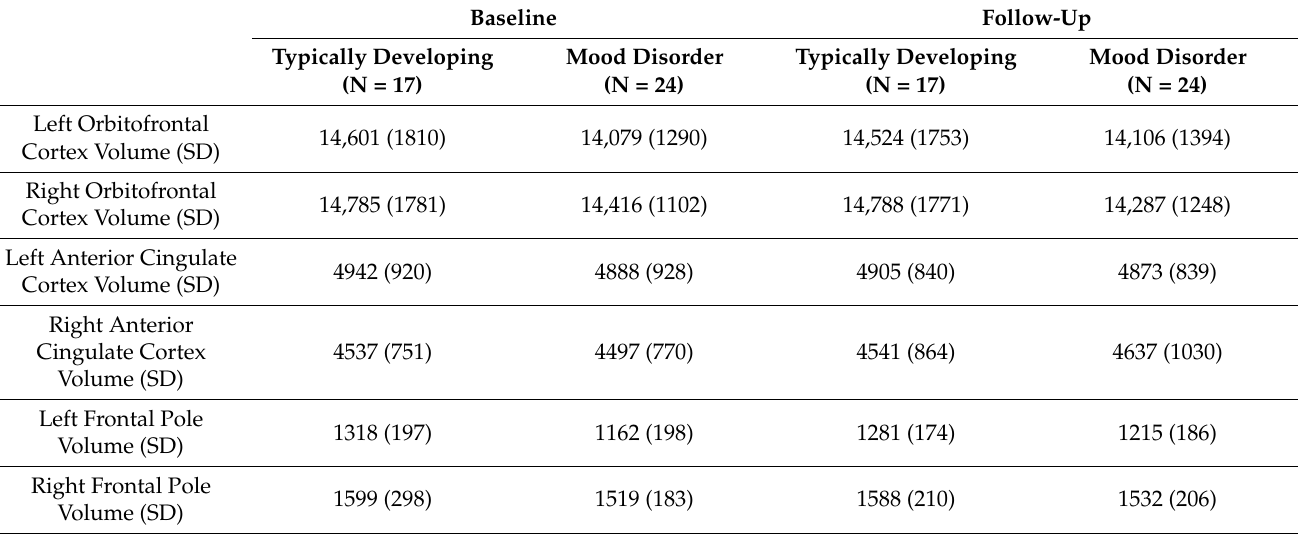
Table 2. Region of interest volumes (mm 3 ) at baseline and follow-up. Baseline